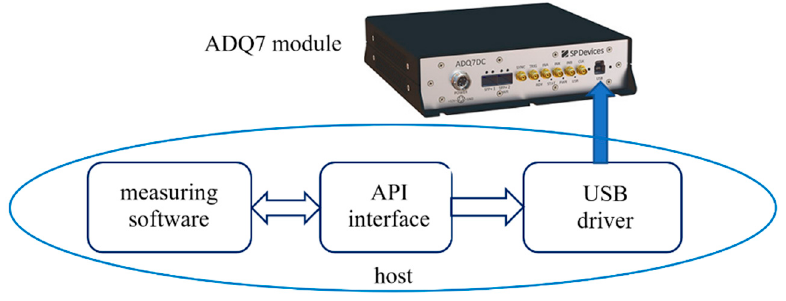
Figure 3. Structure of communication with the ADQ7 module via API.